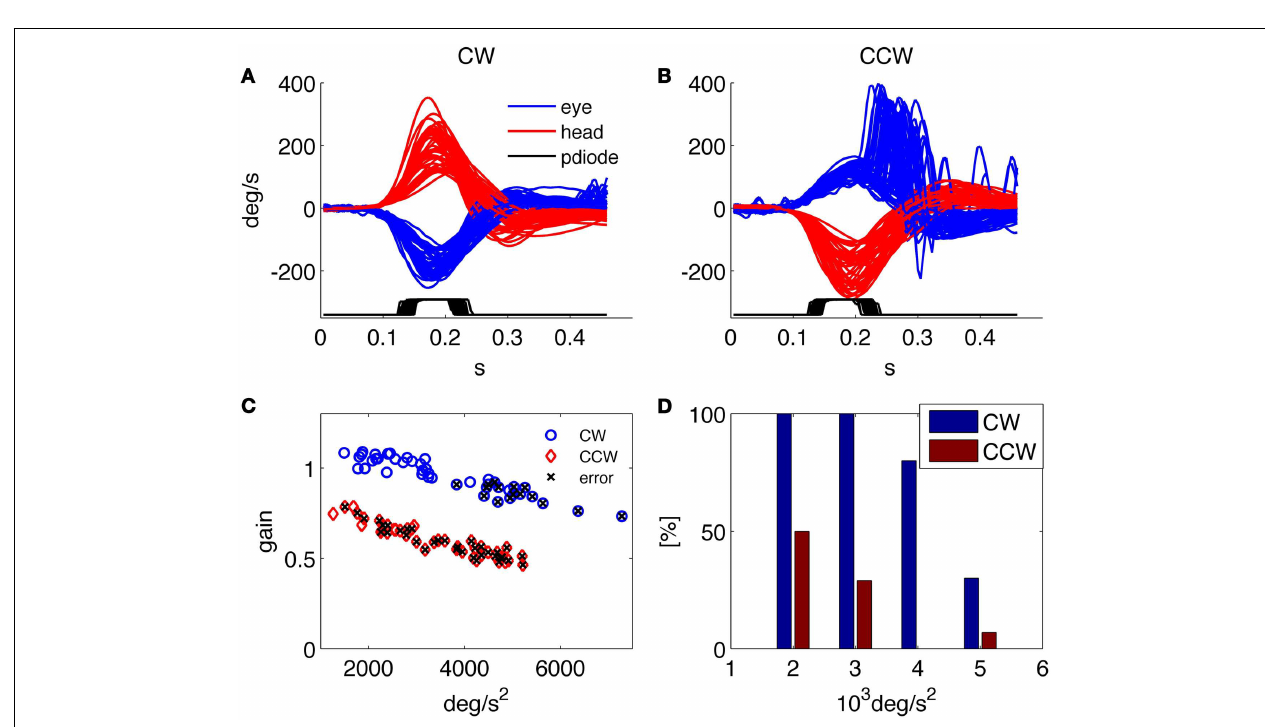
x indicates wrong reading. (D) Percentage of correct answers for each acceleration bin. Overall percentage of correct answers: 18% toward the affected side, 62% toward the